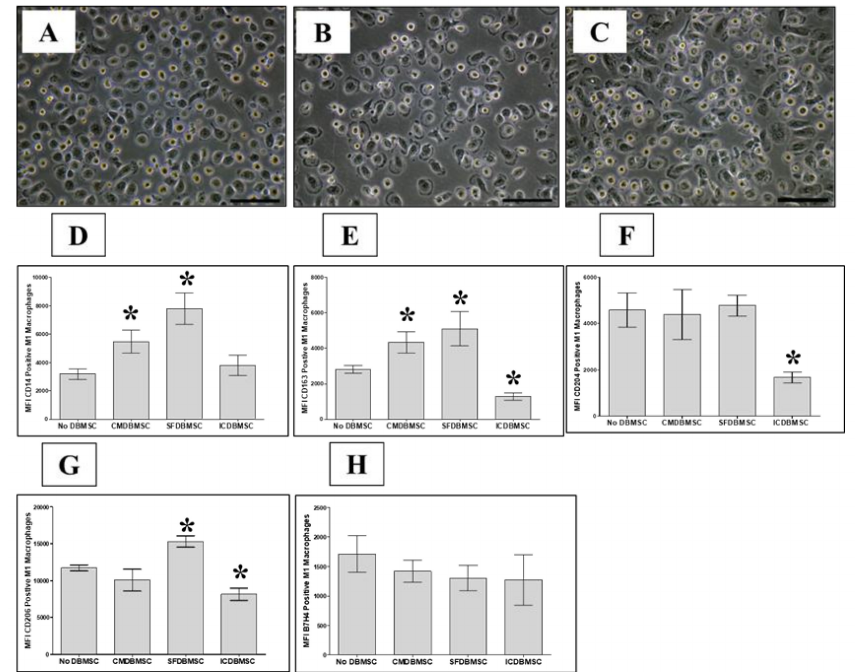
Figure 3. Reversibility effects of DBMSCs on macrophage differentiation. Human monocytes differentiated into macrophages by GM-CSF in the presence of DBMSCs. DBMSCs were removed